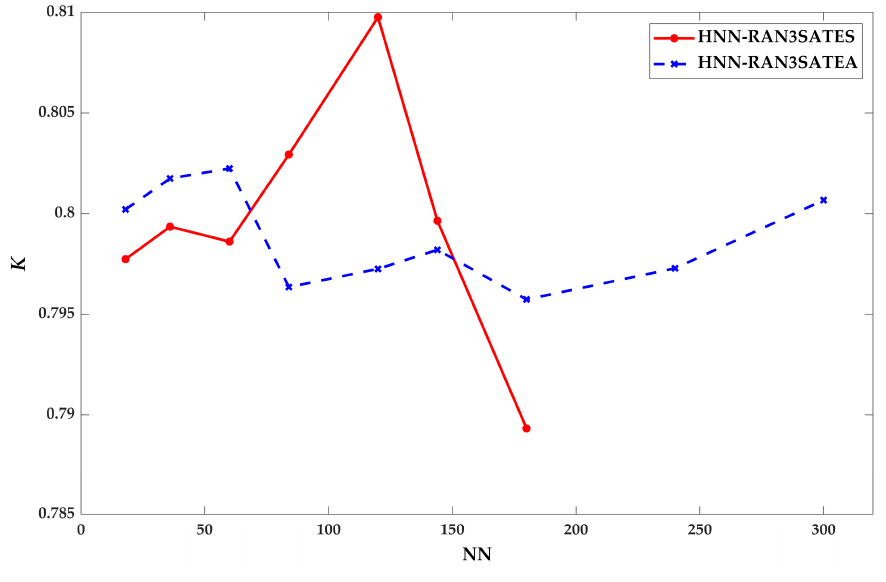
Figure 13. K (Kulczynski) for HNN-RAN3SAT model.